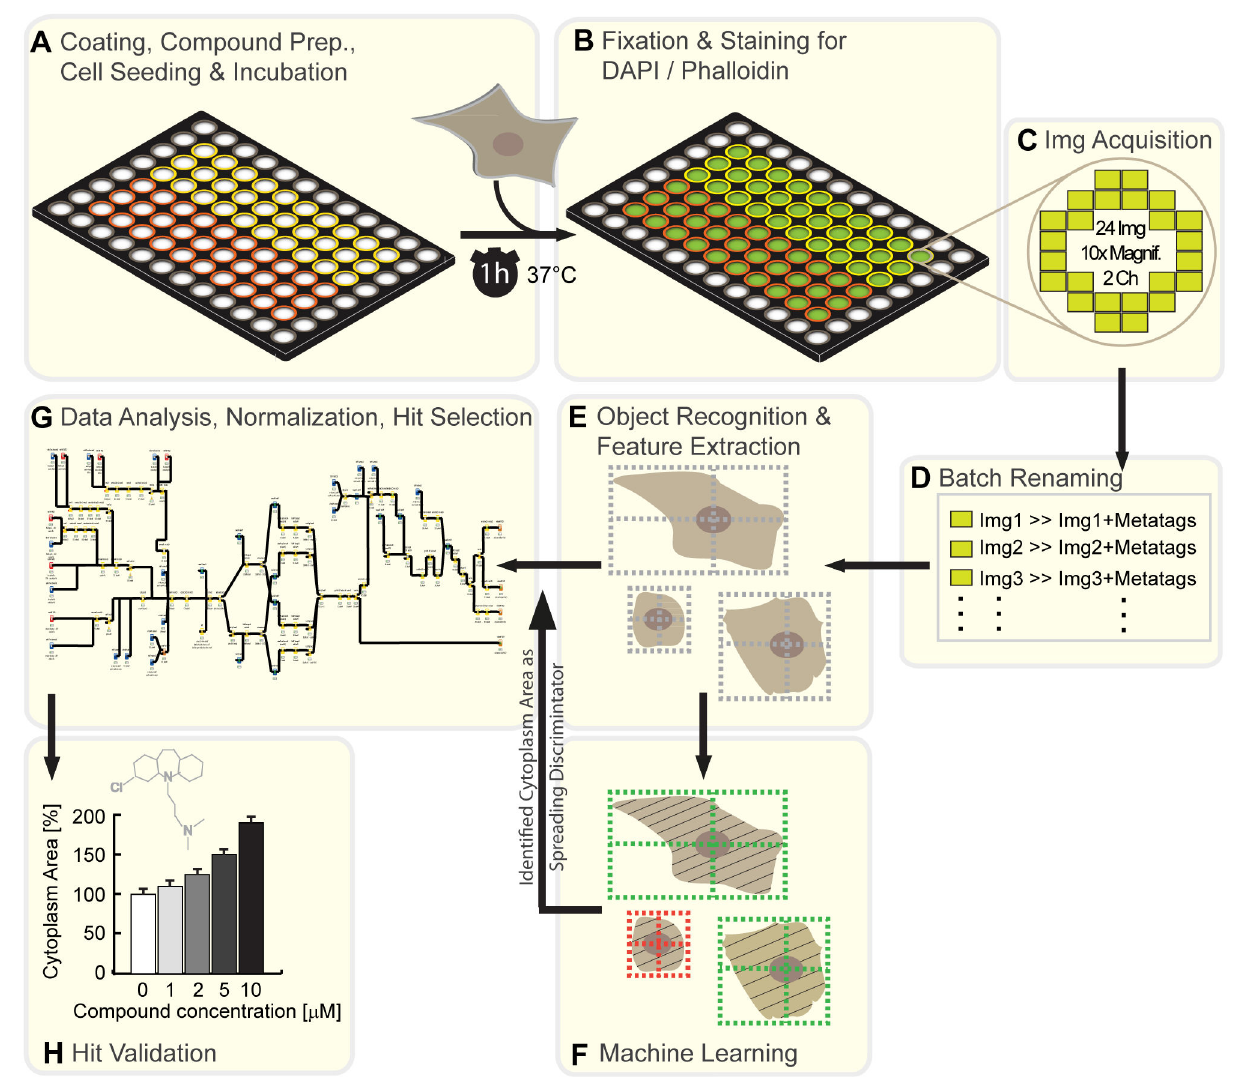
Figure 1. High Content Screen (HCS) for cell spreading of 3T3 fibroblasts. The major steps of the screen are illustrated: ( A ) Swiss 3T3 cells are incubated with different compounds in 96-well plates on two different substrates (yellow/red). Each column contains the same compound. The outer wells are left empty. ( B ) After 1h incubation at 37°C/5% CO paraformaldehyde in isotonic phosphate buffer and stained with DAPI (nuclei) and Phalloidin (F-actin). ( C ) 24 images are acquired per channel from each well using the 10x objective. No images are taken in the center or at the border of the well. ( D ) Image file names are being padded with meta-tags containing location and treatment information. ( E ) Using a custom developed software pipeline in Cell Profiler , cell bodies and cell nuclei are automatically detected. Phenotypic features are extracted and stored in an SQLite database, annotated with its corresponding meta-tags and linked to its compressed image files. ( F ) The SQLite database can be imported into Cell Analyst . Machine learning algorithms can be used to detect the most prominent cell features that are changed in a certain condition. Furthermore, it allows for an automated categorization of cells by their phenotypes (e.g. spread vs. unspread cells). ( G ) A data analysis pipeline was constructed in KNIME to automatically import, normalize and visualize the data. Scatter plots/matrices allow for outlier removals and hit selections. Pivot tables of normalized data / hit lists are generated and exported into .csv files for direct import into statistical analysis software. ( H ) All hits were validated in dose-response assays with 6 instead of 3 replicates. doi: